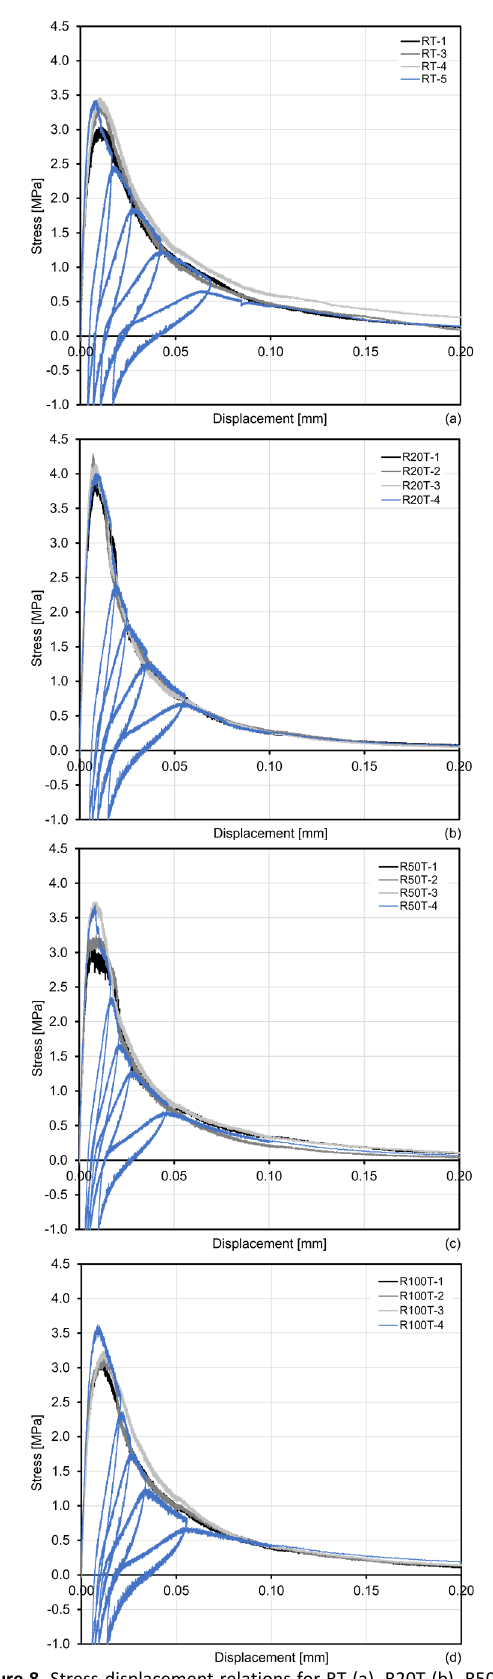
Figure 8. Stress ‐ displacement relations for RT (a), R20T (b), R50T (c) and R100T (d). Cyclic test results are presented for RT ‐ 5, R20T ‐ 4, R50T ‐ 4 and R100T ‐